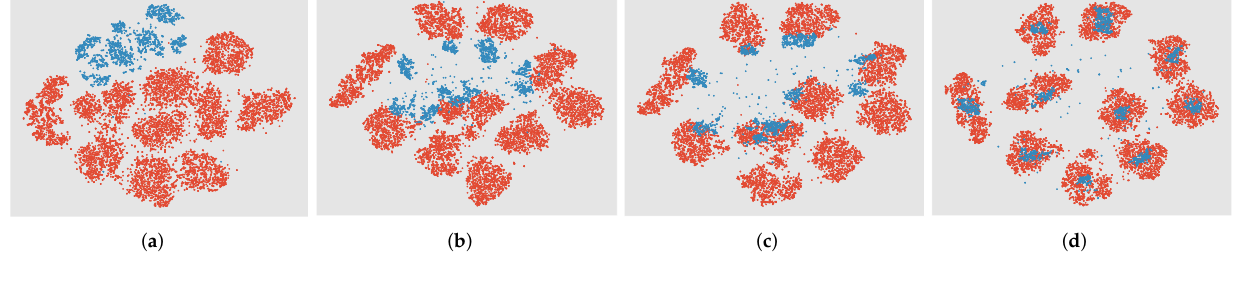
Figure 2. The t-SNE visualizations of content features generated by the proposed method with the increse of the epoch on MNIST → USPS. Red and blue points indicate the source and target samples, respectively. ( a ) Epoch:0, ( b ) Epoch:25, ( c ) Epoch:50, ( d )